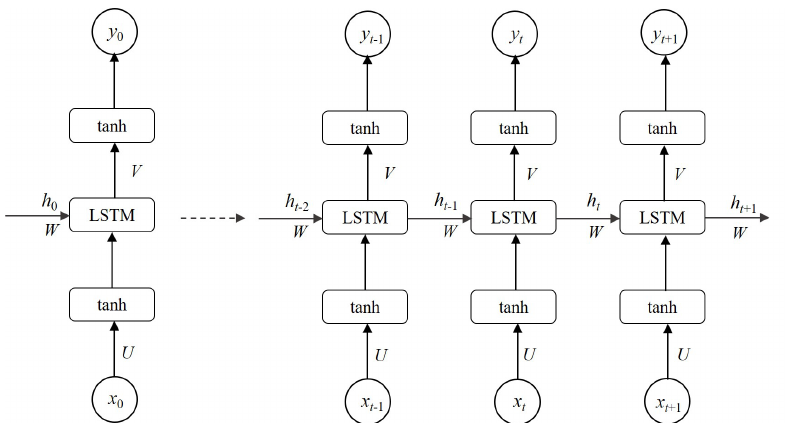
Figure 2. The unfold architecture of one-layer standard